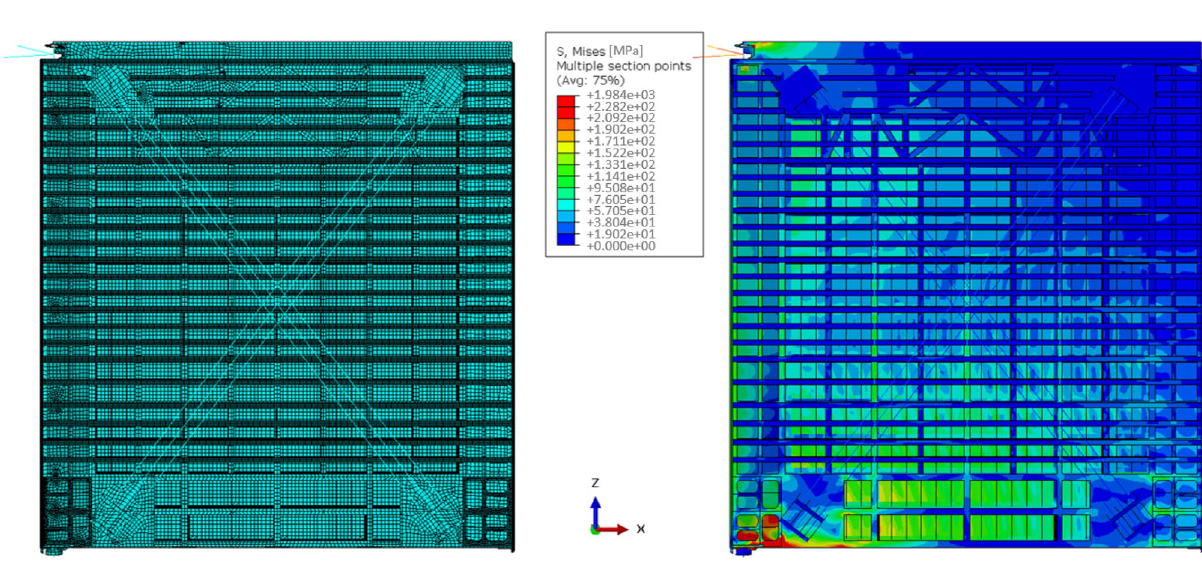
Figure 9. Stress magnitude of miter gate